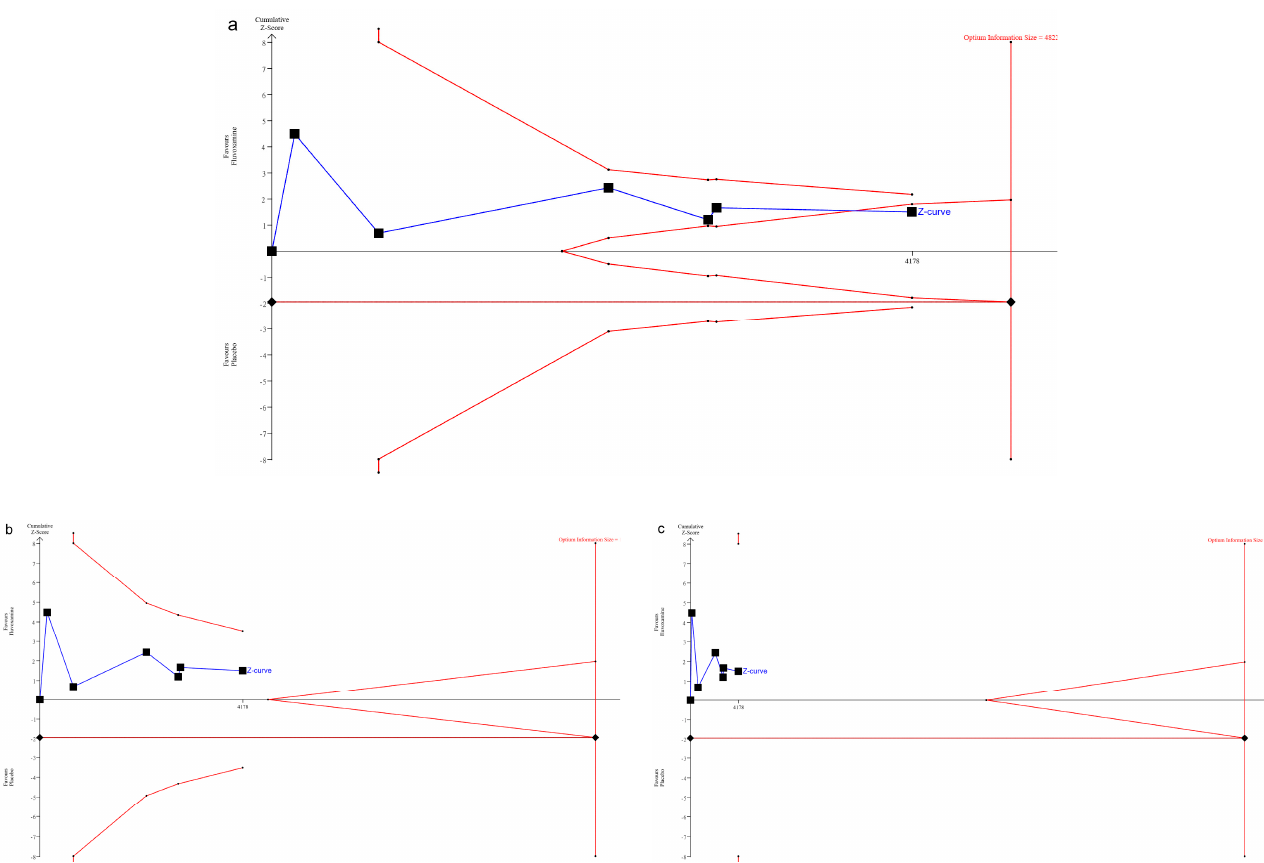
Figure 5. ( a ). Trial sequential analysis of fluvoxamine on the primary outcome using 30% relative risk reduction threshold. ( b ). Using the 20% relative risk reduction threshold. ( c ). Using the 10% relative risk reduction threshold.